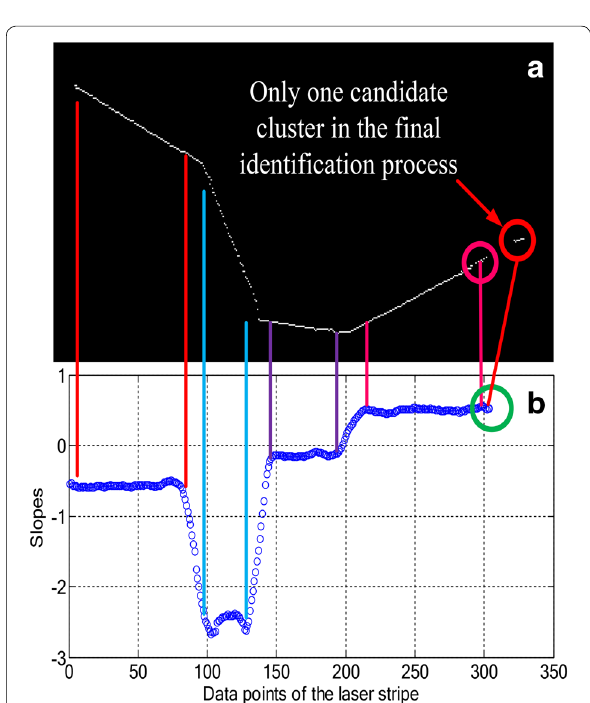
Figure 11 Illustration of the slope fluctuations of the linear segments of the WSP: a example of the WSP containing different linear pieces, b slope fluctuations of the linear segments of the WSP